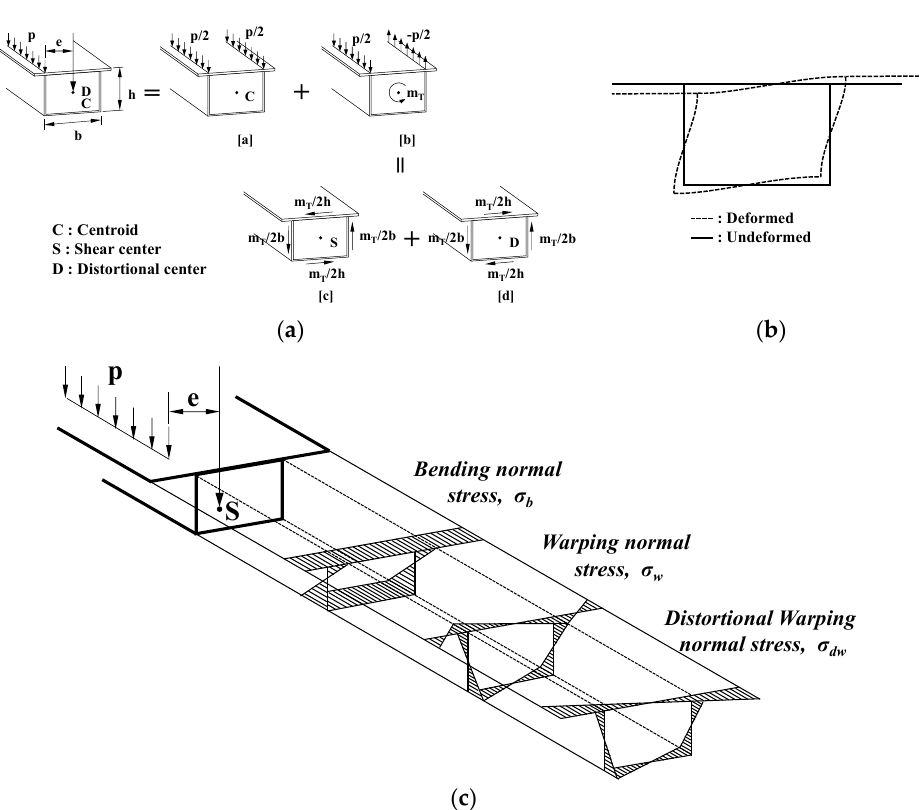
Figure 1. Distortional behavior of steel-box girder bridges. ( a ) Decomposition of torsional moments, ( b ) cross-sectional distortion, and ( c ) normal stress components from applied eccentric loading.